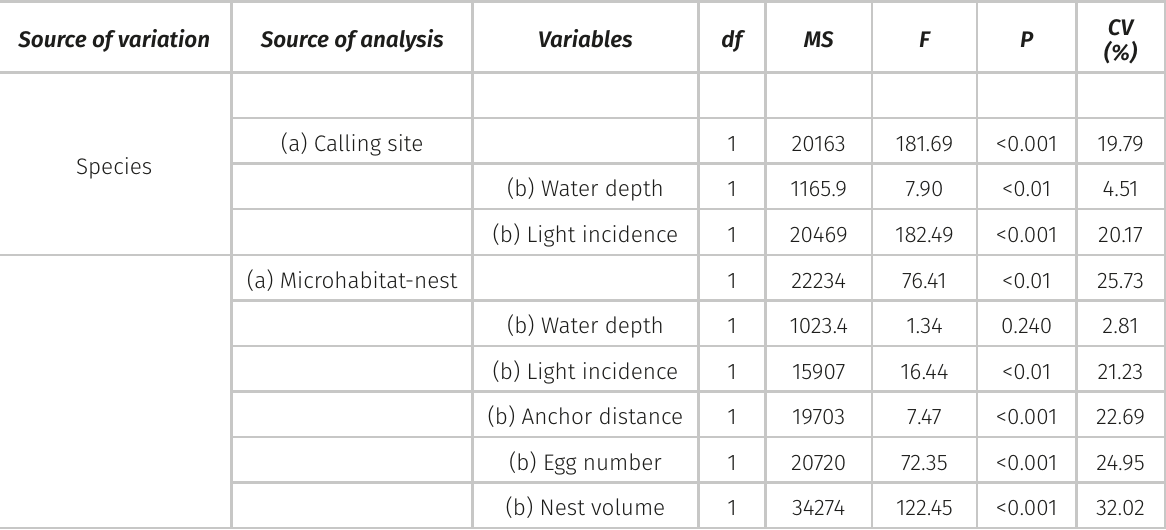
Table II. Permutational (a) MANOVA and (b) ANOVAs based on the Bray–Curtis similarities of the multivariate data on calling sites and microhabitat-nest variables from P. aff. albonotatus and P. santafecinus . The component of variation (CV) attributable to each source of variation is also